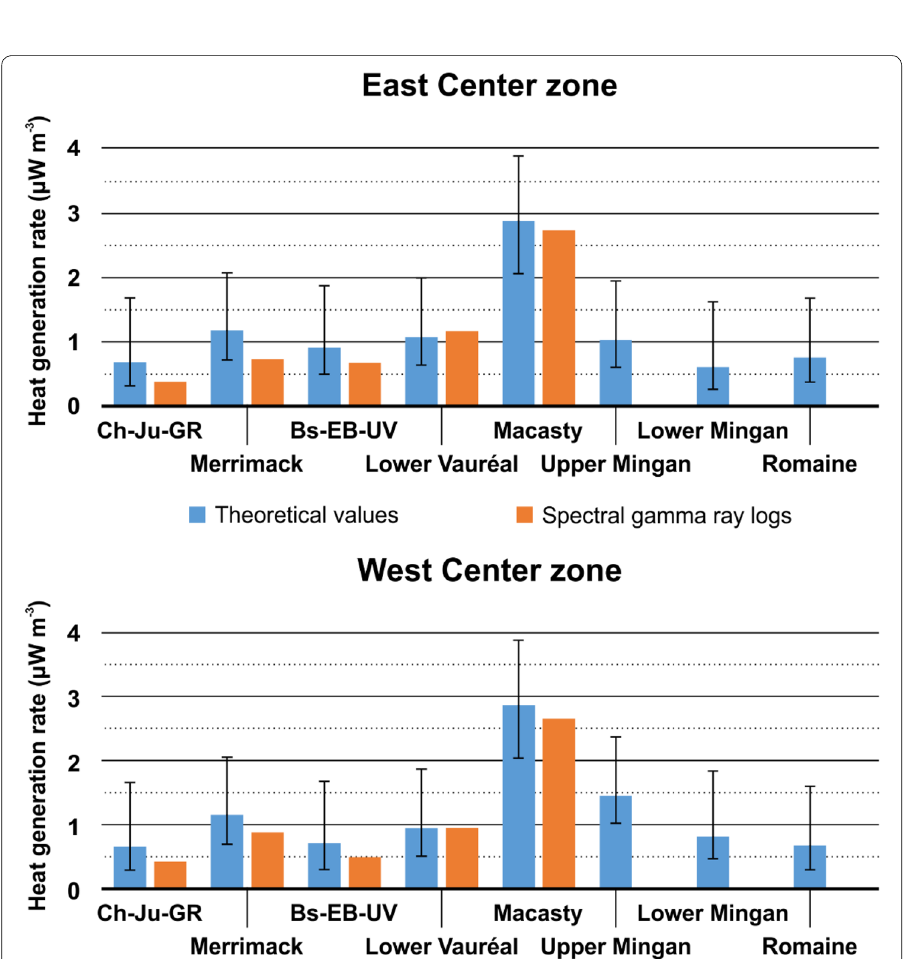
Fig. 8 Heat generation rates of thermal units from spectral gamma ray logs compared to theoretical value for each lithology. Error bars correspond to heat generation rates calculated with Q 25 and Q